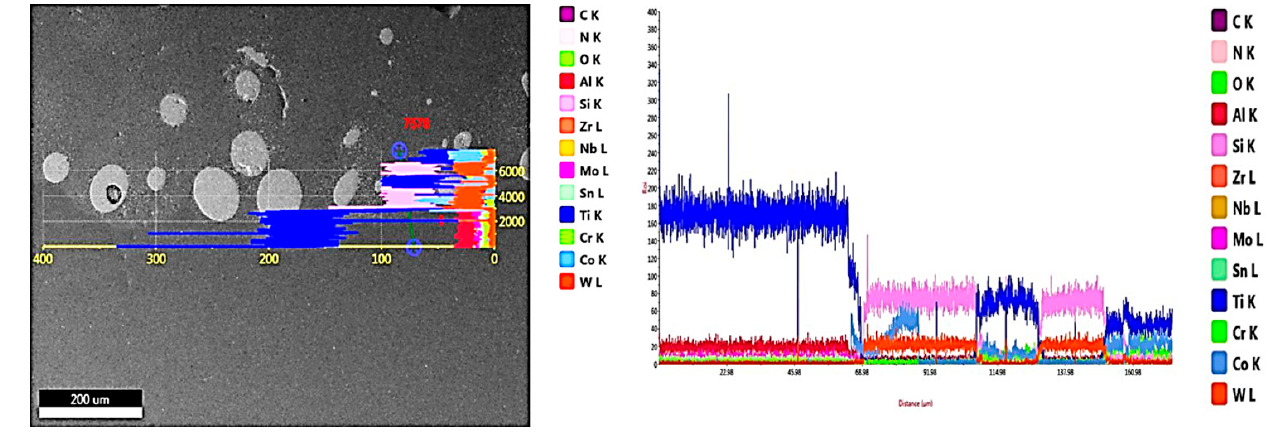
Figure 12. EDAX line scan along the cross-section of the MMC layer of sample 2.